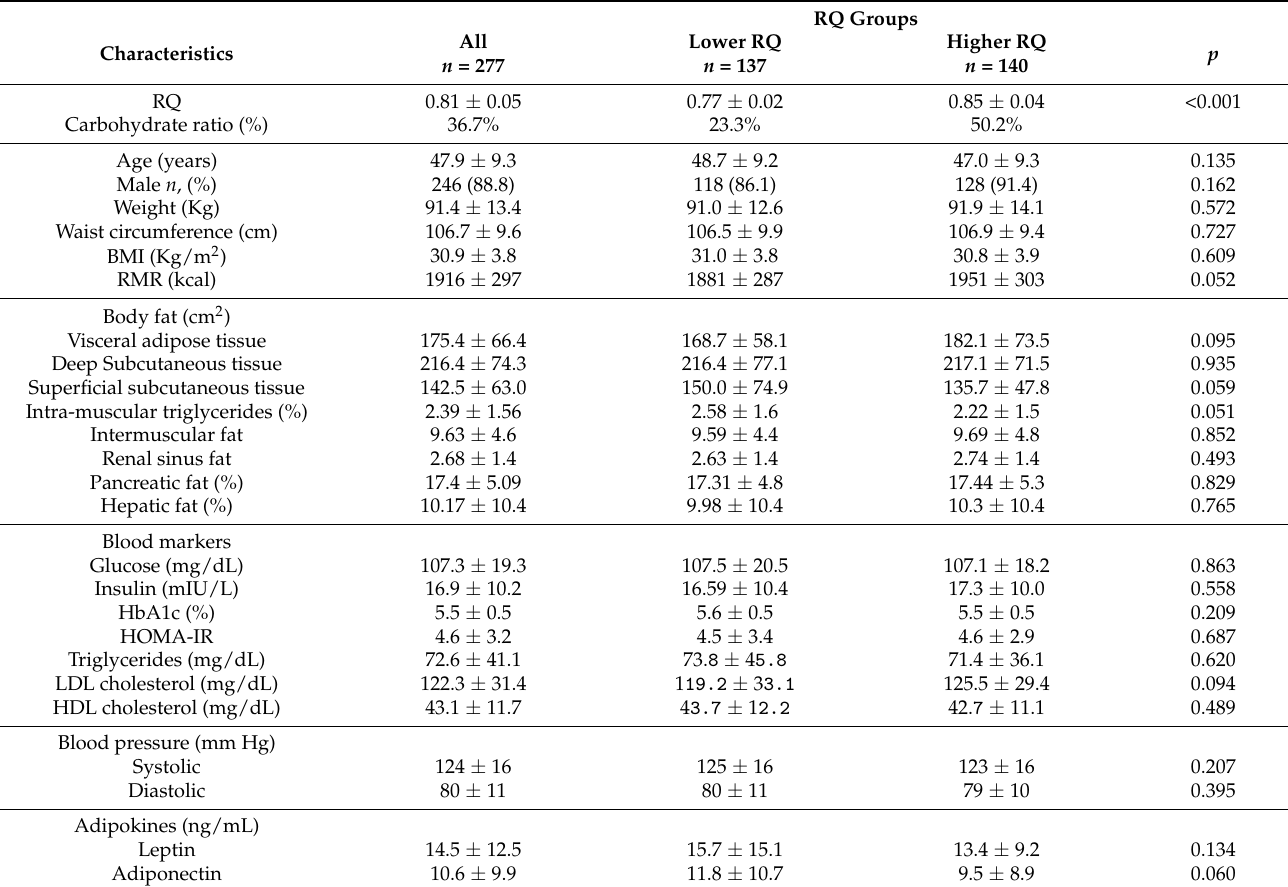
Table A2. Baseline characteristics of the study population across RQ